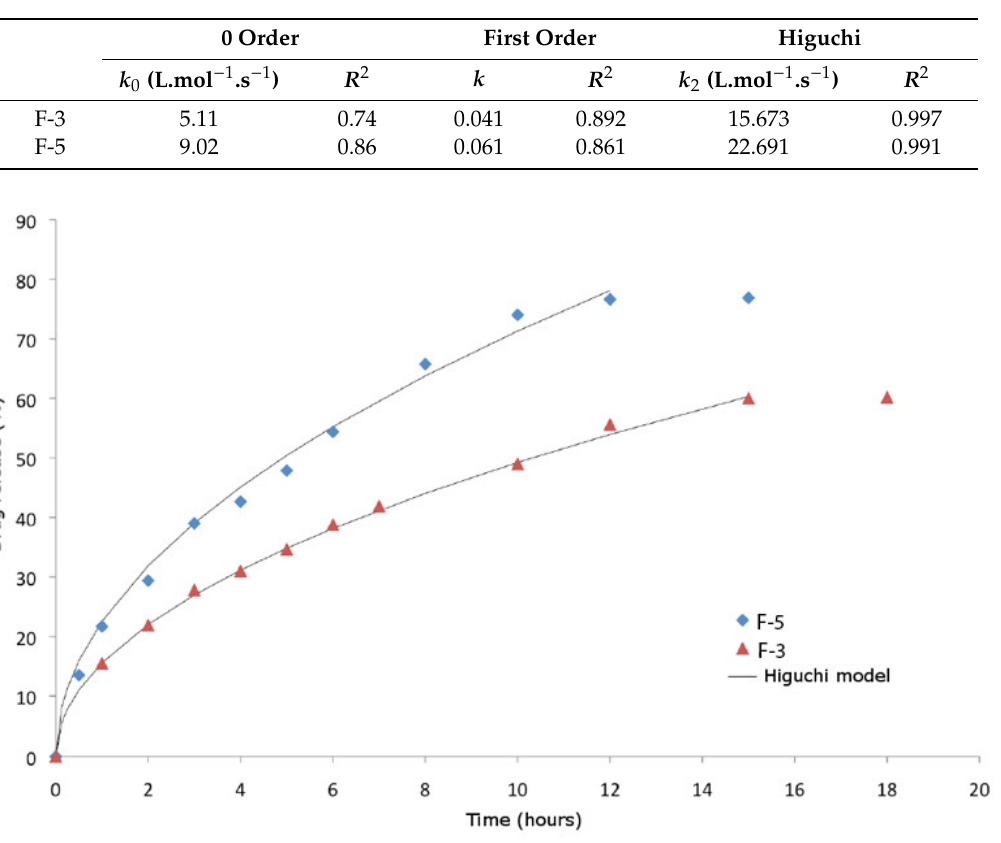
Table 5. Stability of the formulation